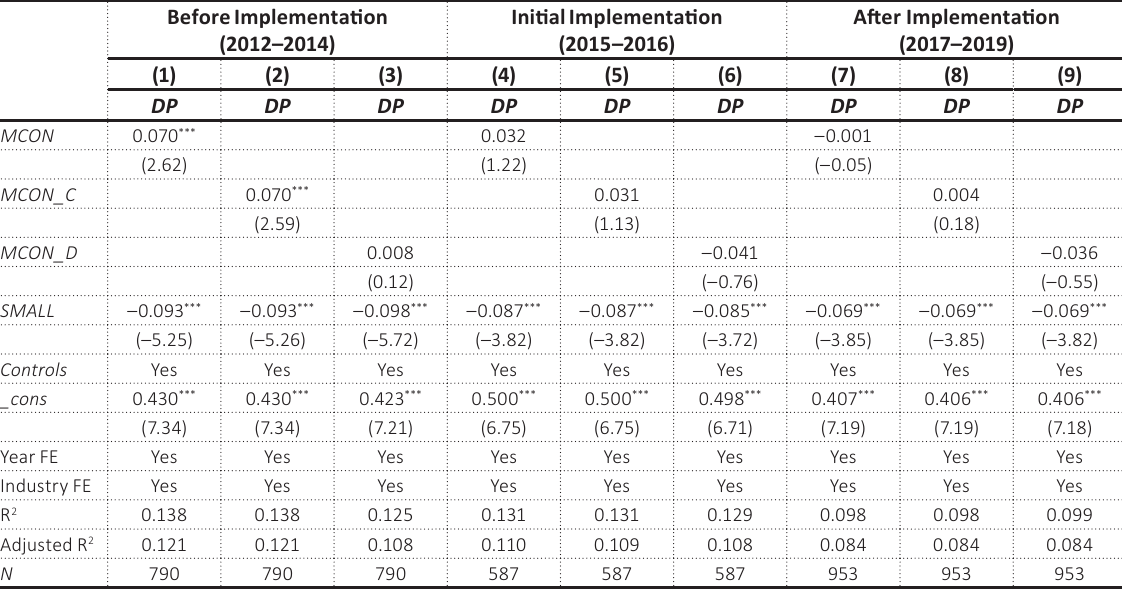
Table B1. Relationship between military-connected firms and debt policy